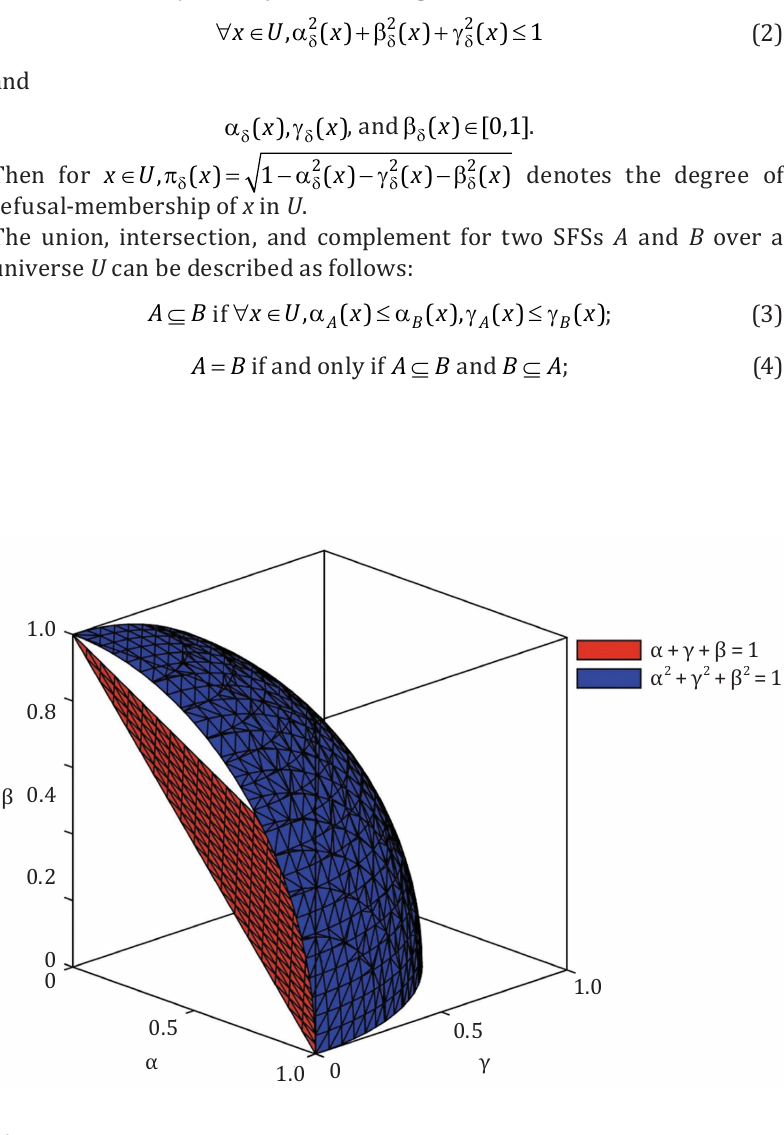
Figure 1. Comparison between spaces of SFS and PFS (Akram,